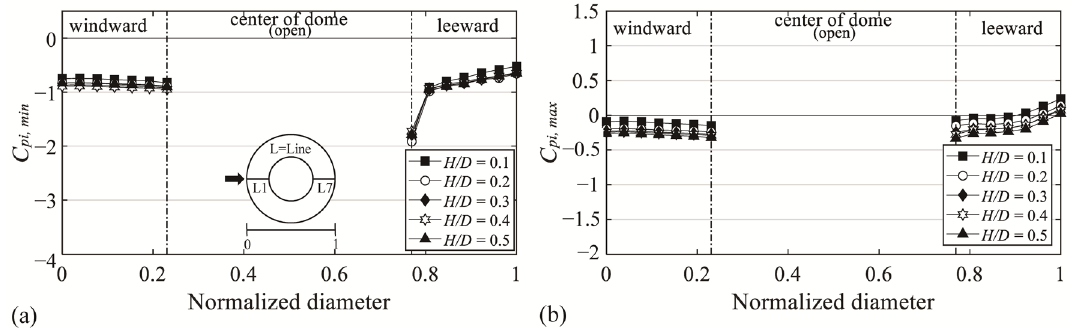
Figure 14. Variation of C pi,min and C pi,max depending on H / D of the central open dome: ( a ) C pi,min of open ratio = 50% and ( b ) C pi,max of open ratio = 50%.